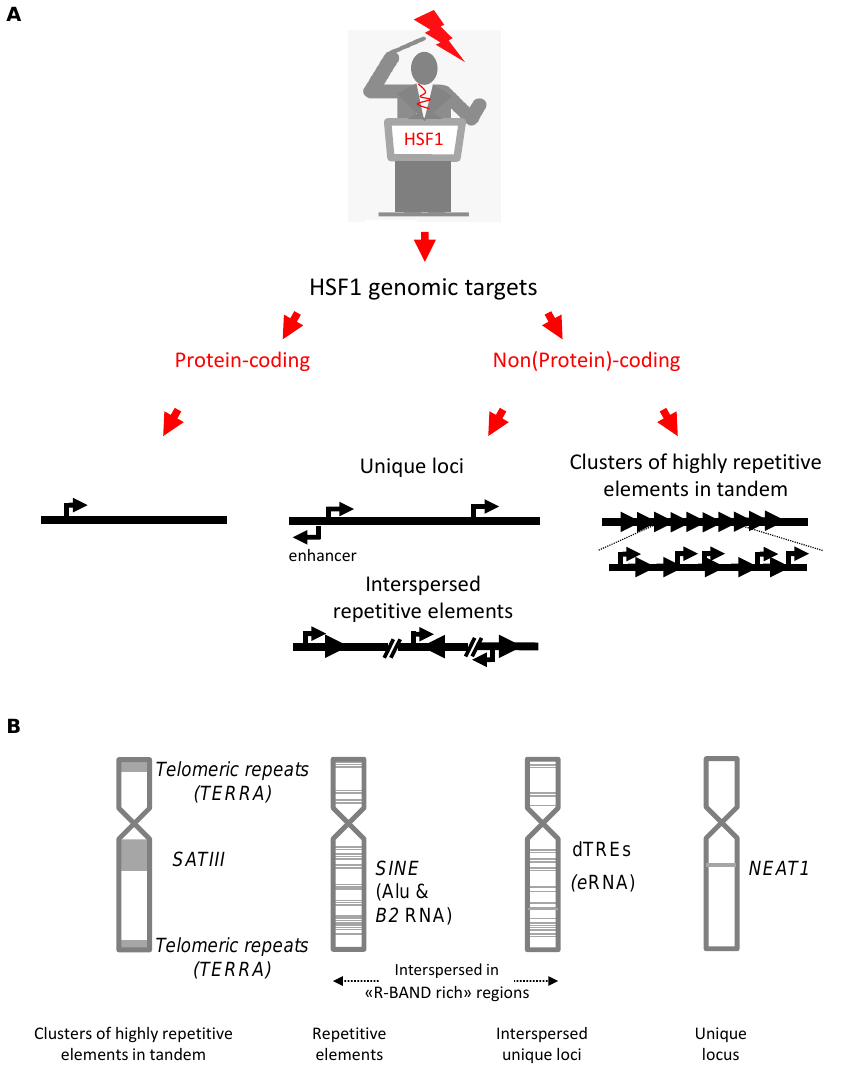
Figure 1. Genomic targets of the HSF1-mediated heat-shock response. ( A ) Several types of genomic sequences are targeted and transcribed by HSF1. They include protein-coding genes, such as HSP genes, and non(protein)-coding sequences. This later group includes non-repetitive elements present at a single locus (e.g., NEAT1 , distal Transcription Regulatory elements (dTREs) transcribed into eRNAs ) and repetitive interspersed elements, present as a thousand copies within gene-rich regions (e.g., SINE s). Finally, non-coding sequences also include clusters of highly repetitive elements in tandem such as SATIII and Telomeric repeats (transcribed into TERRA), located at pericentric and telomeric regions. ( B ) Distribution of non-coding sequences along human chromosomes. SATIII lncRNA and TERRA are transcribed from large regions located at pericentric and telomeric regions, respectively (primarily from chromosome 9 in the case of SATIII lncRNA). SINE sequences are mainly present in the gene-rich and GC-rich regions (R-bands). eRNA s are transcribed from the dTREs present upstream of the promoter and gene transcription start sites (TSS) and are, therefore, likely to be widespread and possibly more abundant in gene-rich regions. The NEAT1 gene is present at a single